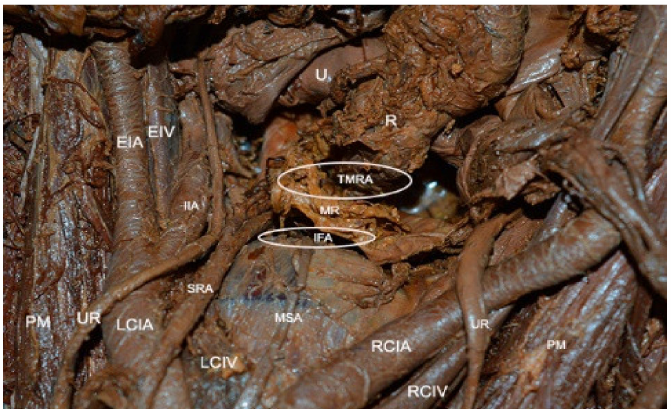
Figure 14. Presacral space (embalmed cadaver). PM—psoas muscle; LCIV—left common iliac vein; LCIA—left common iliac artery; UR—ureter; MSA—middle sacral artery; PR—promontory; RCIV—right common iliac vein; SRA—superior rectal artery; RCIA—right common iliac